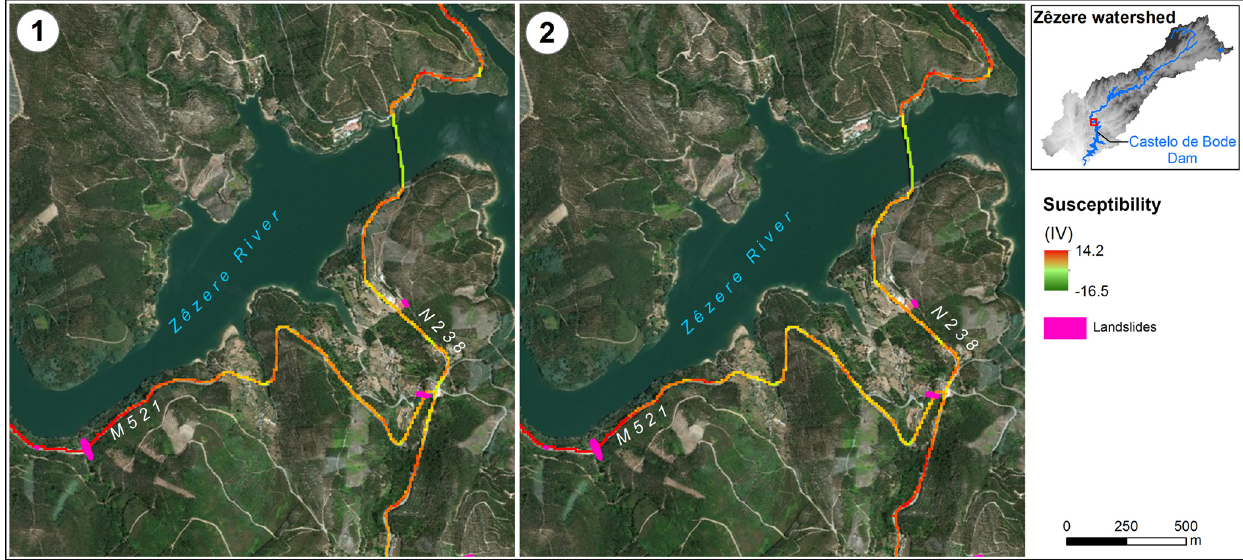
Figure 10. Examples of the landslide susceptibility of the road network in the Ferreira do Zêzere municipality. 1 – LSRN1; 2 –